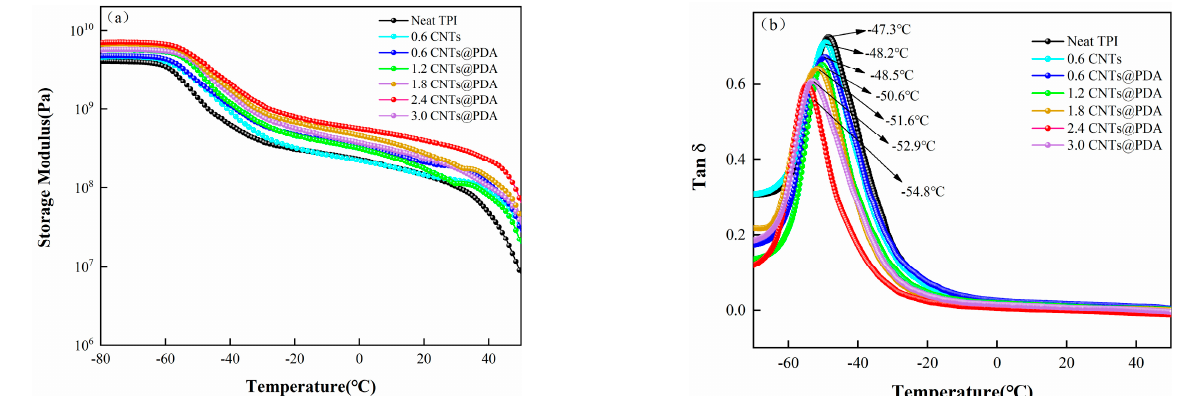
Figure 11. DMA curves of ( a ) storage modulus (E ′ ) and ( b ) loss factor (tan δ ) of TPI